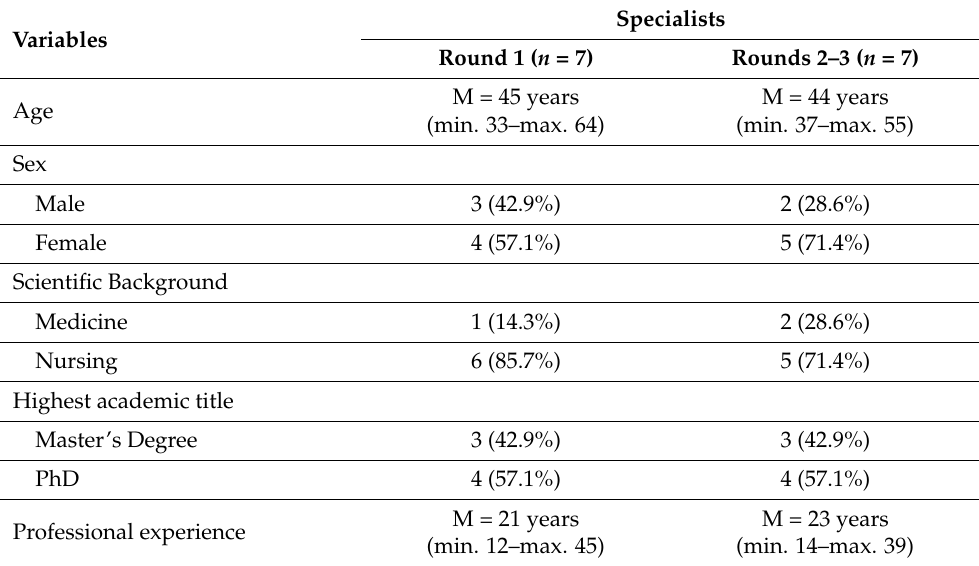
Table 1. Characterization of the Delphi panel